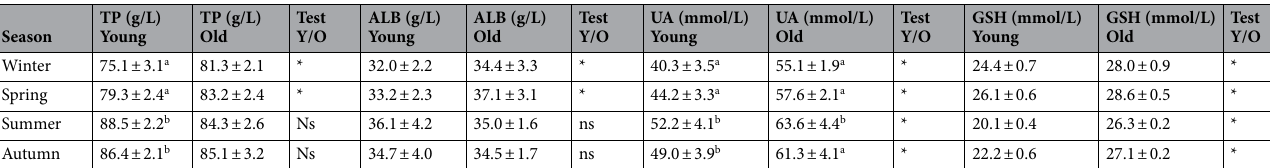
Table 5. Concentration of nonenzymatic antioxidants in the blood serum of younger and older bulls in relation to different season (mean ± SD). Explanation: Values with different letters (a, b) differ significantly between rows at P < 0.05. TP total protein, ALB a lbumins, UA uric acid, GSH reduced glutathione. Test—t- Student’s test, ** P ≤ 0.01; * P ≤ 0.05; ns = P > 0.05.